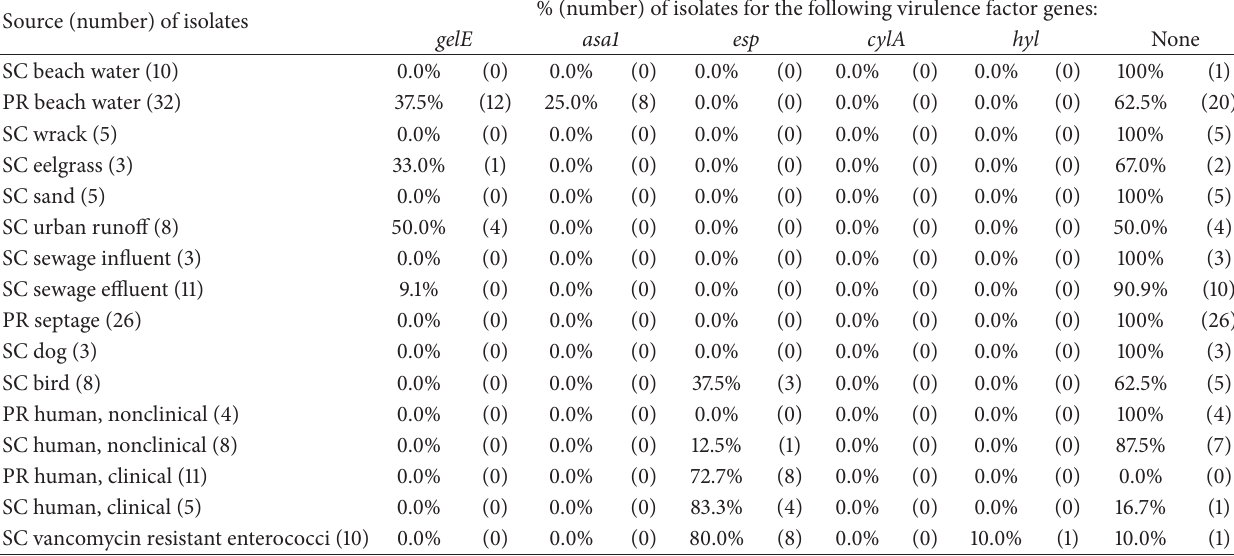
Table 4: Distribution of virulence factor genes among E. faecium isolates from Southern California (SC) and Puerto Rico (PR). Source (number) of